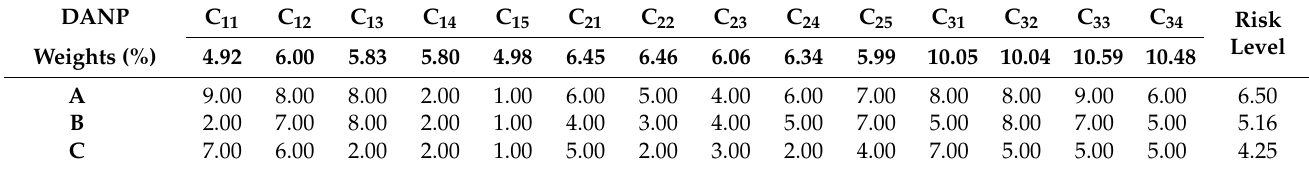
Table 7. DANP-based AKI risk assessment model with three assumed